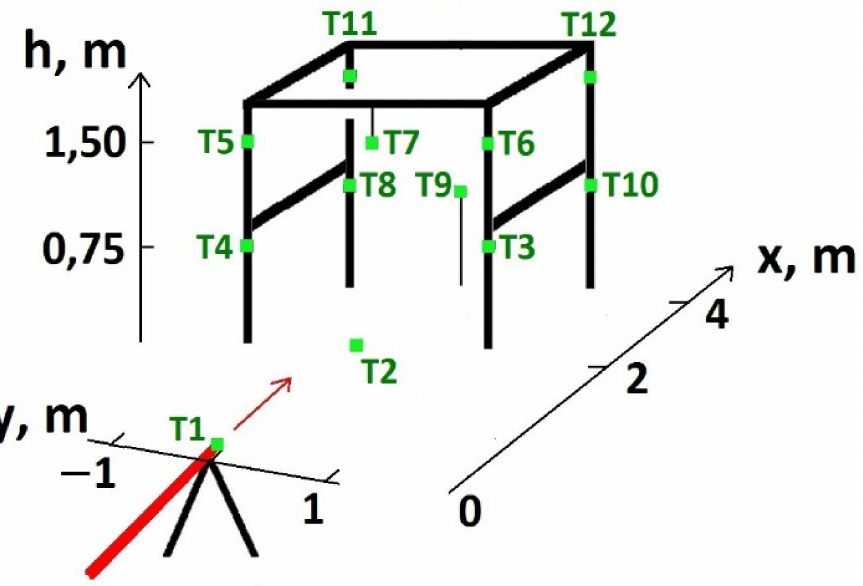
Figure 3. Schematic representation of the test rig used to determine the ambient temperature drop during LNG